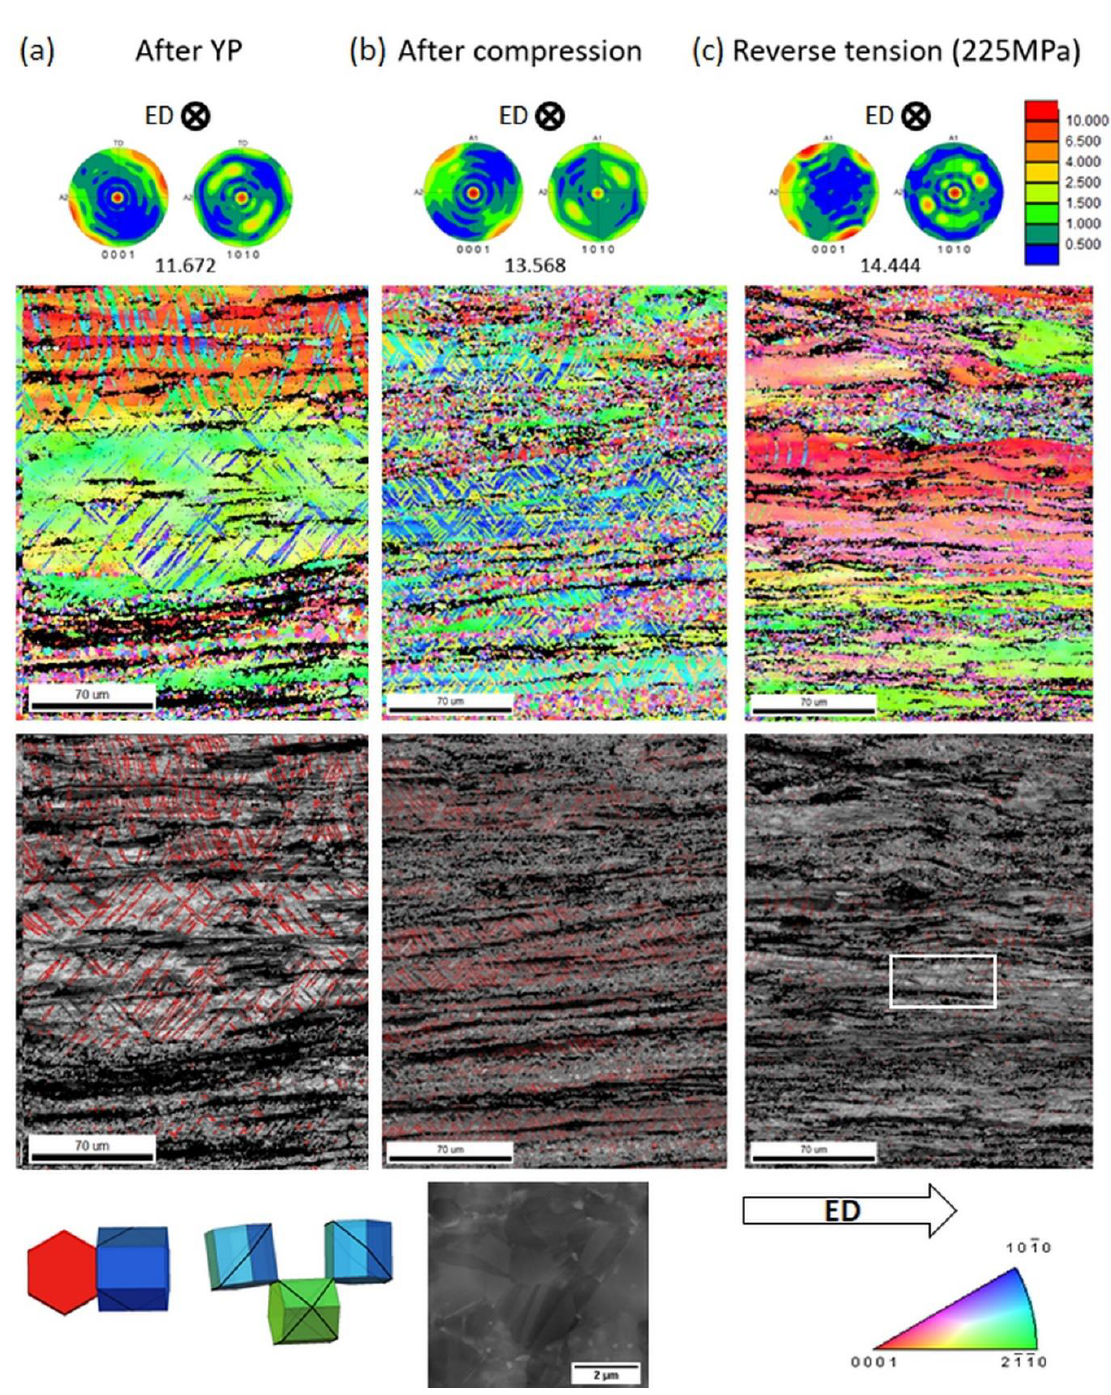
Figure 4. Development of the microstructure during cyclic loading of WZ42 alloy, particularly after ( a ) yield point (YP), ( b ) compression part, and ( c ) reverse tensile loading up to 225 MPa. Schematic view of hexagonal close-packed lattices are used for representation of activated twin variants with respect to parent grain orientation. Extra BSE image represents activation of twinning in dynamically recrystallized (DRX) grains.